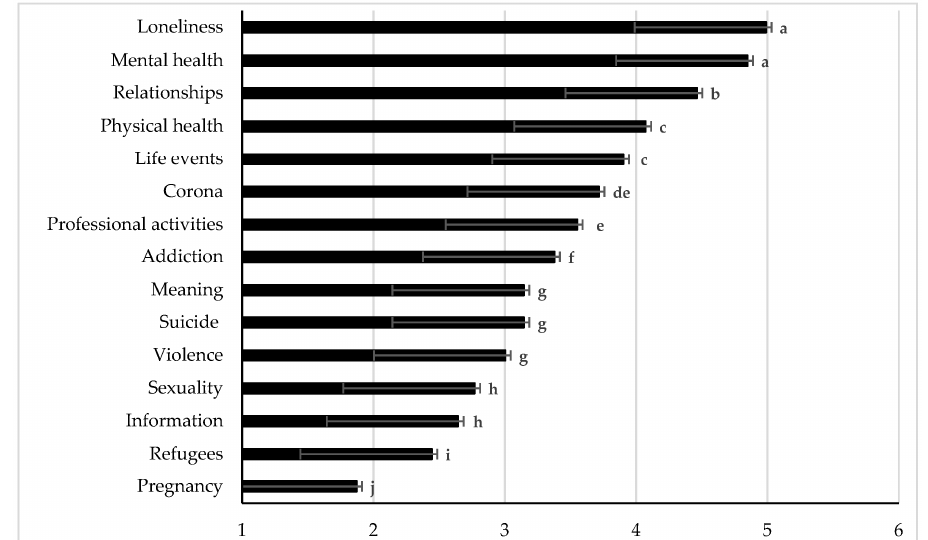
Figure 1. Counselors’ rating of the frequency of topics thematized by helpline callers during the second wave of COVID-19 infection in Austria ( n = 374). Note: Counselors rated the frequency of each topic on a six-point scale from 1 = “never” to 6 = “always”. Data are shown as least square means (LSM) ± standard error of the means. a,b,c,d,e,f,g,h,i,j Different superscripts indicate differences among LSM of the topics at p < 0.05 after Bonferroni-correction.